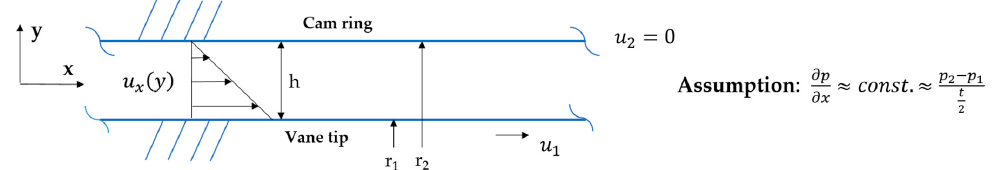
Figure 5. Simplified model 2 to obtain an analytical solution for u ϕ ( r ) in the radial gap, which is here approximated by u x ( y )